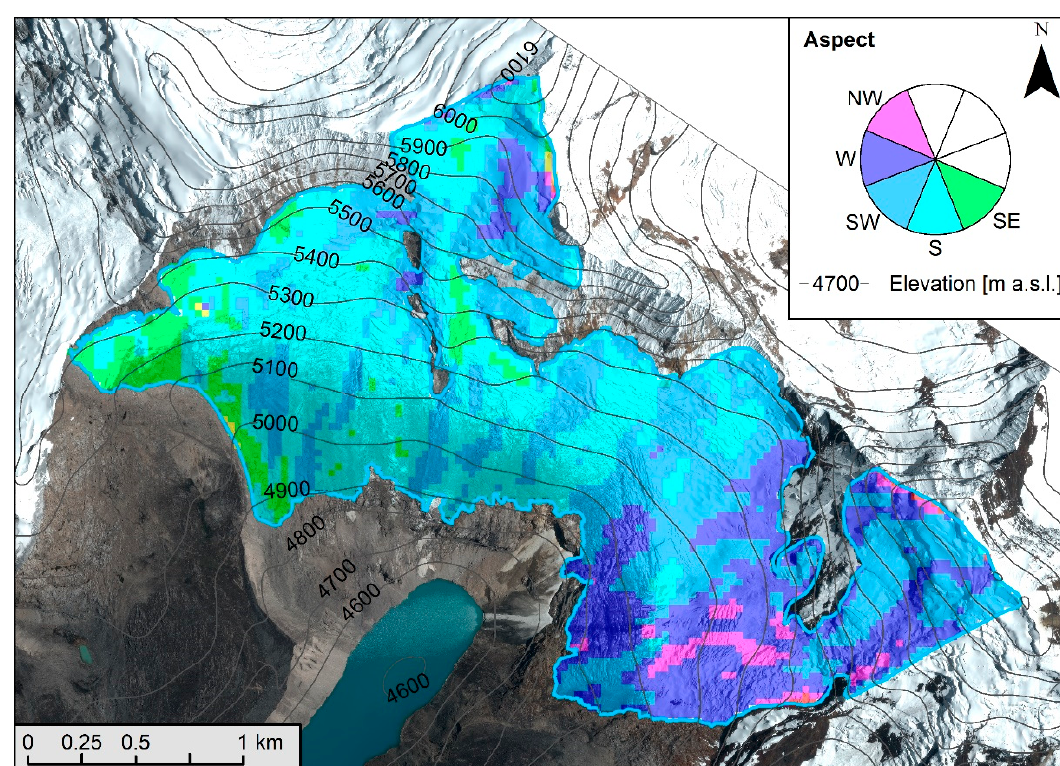
Figure 2. Glacier slope map.